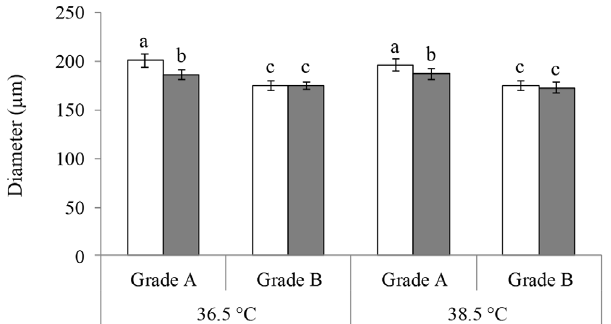
Figure 2. Effect of temperature during in vitro maturation and antioxidants in embryo culture on diameter of blastocysts from Grade A or Grade B oocytes matured at either 36.5°C (n = 152) or 38.5°C (n = 165). The error bars represent the standard error of means and bars with different letters are significantly different at p<0.05. The white bars represent the embryo culture media with antioxidants, whereas the gray bars represent the antioxidants free